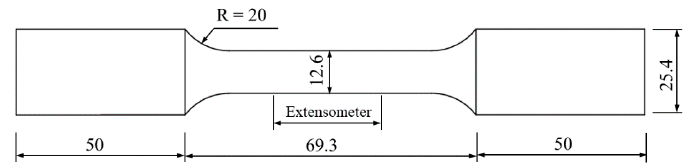
Figure 3. Geometry of SRB specimen (Unit: mm).